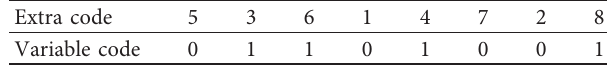
Table 2: The result of dual-structure coding